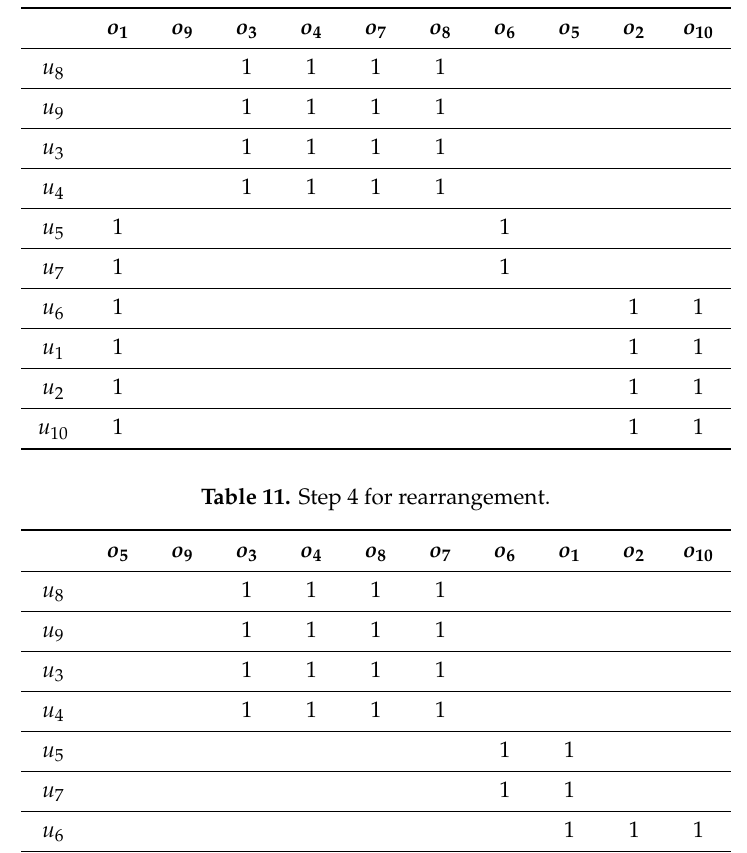
Table 10. Step 3 for rearrangement.